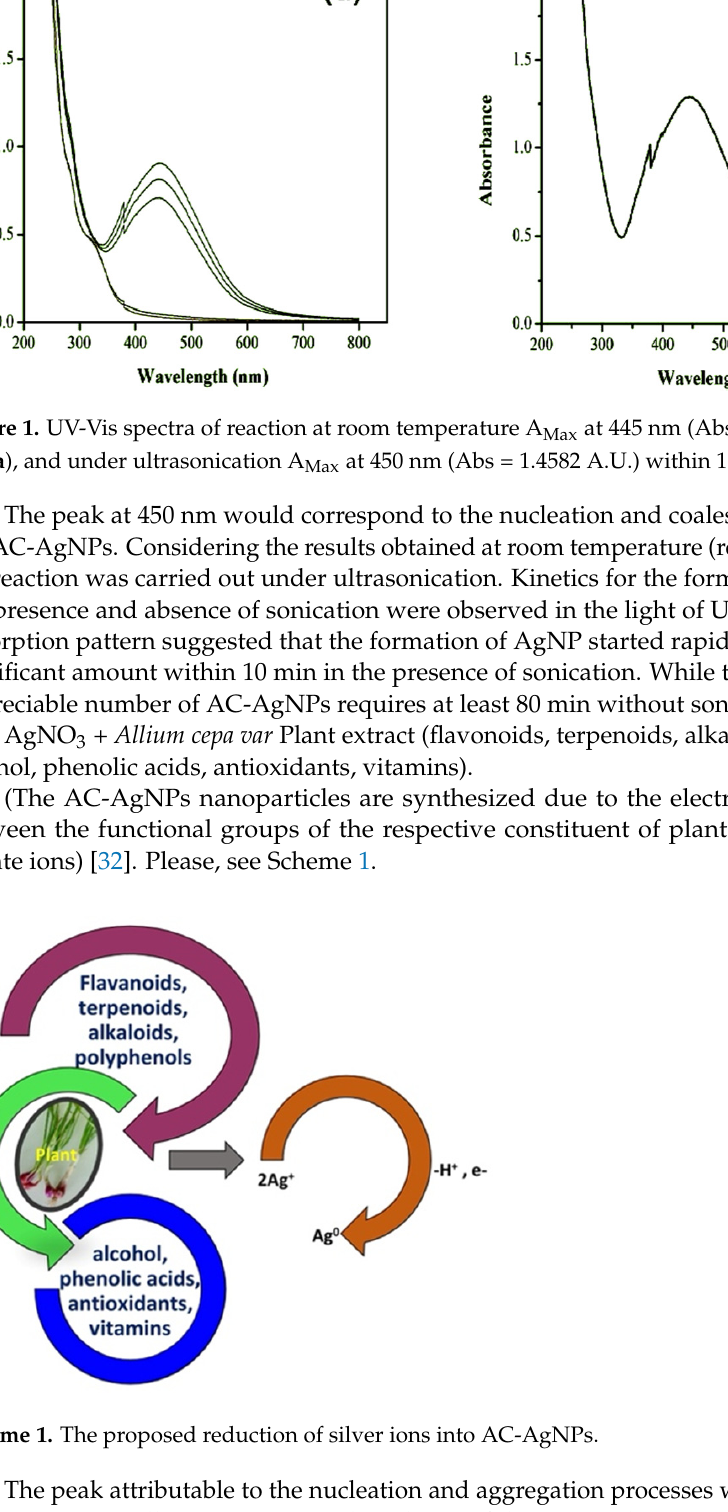
Figure 1. UV-Vis spectra of reaction at room temperature A h ( a ), and under ultrasonication A